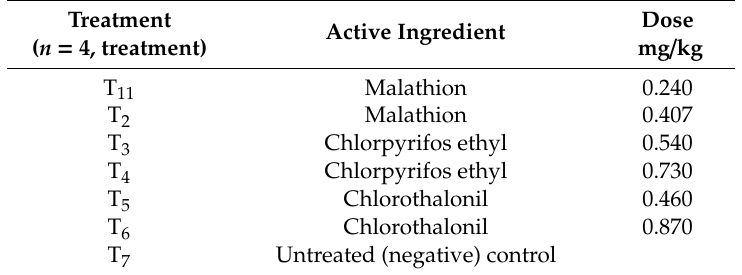
Table 2. Pesticide treatments, dose, in prickly pear pad crop.